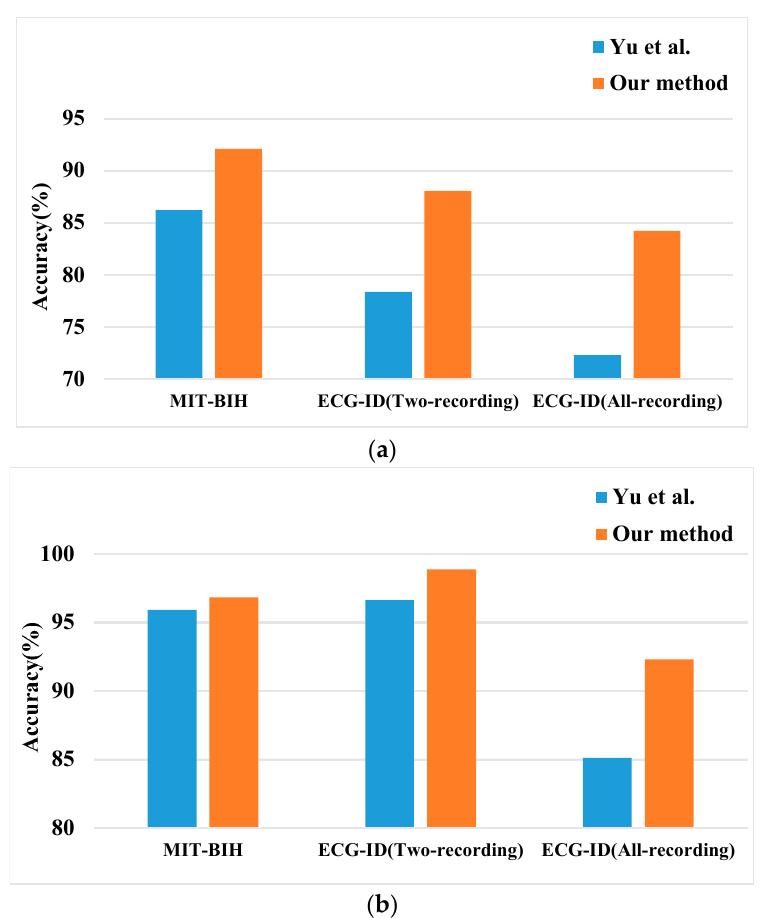
Figure 13. Performance comparison of the proposed method with the approach in reference ( a ) Single-heartbeat identification accuracy comparison; ( b ) Multiple-heartbeat identification accuracy comparison.